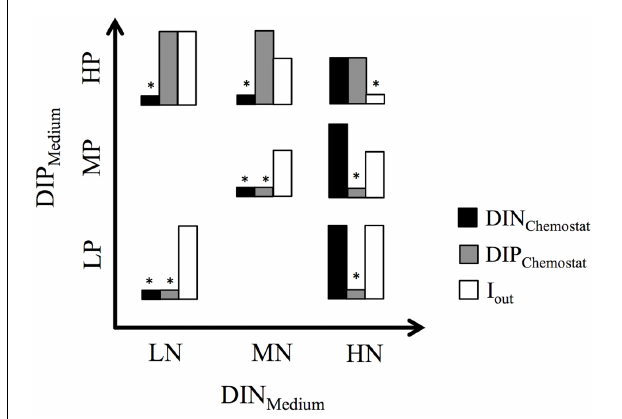
FIGURE 1 | Bar graphs show the relative distribution of nutrient concentrations (DIN Chemostat , DIP Chemostat ) and light penetration (I out ) in the seven chemostat experiments. ∗ above bars indicate the resulting resource limitation. Experimental set-up is based on three levels of dissolved inorganic nitrogen (DIN Medium ) and phosphorus (DIP Medium ) in the mineral medium supplied to the